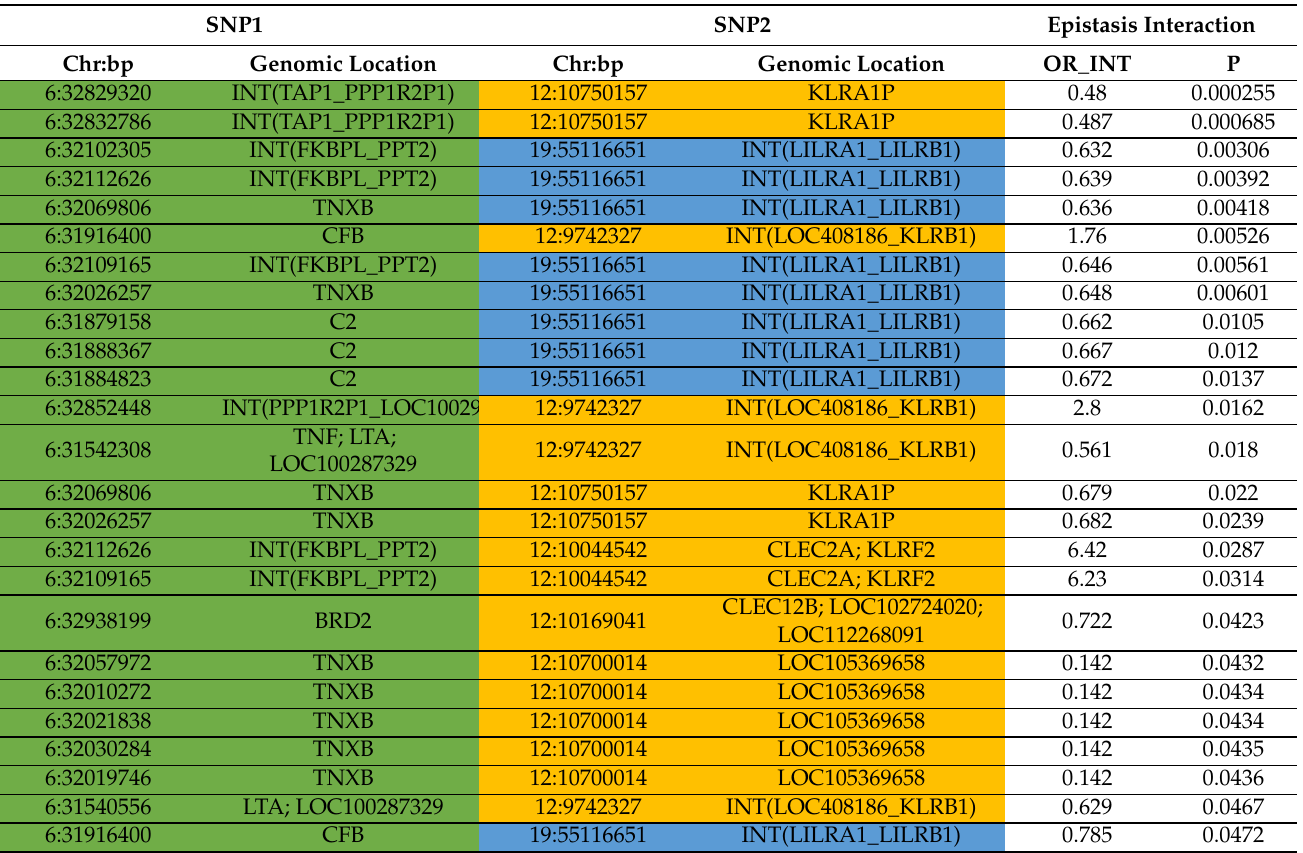
Table 6. Epistasis results on the panel of SNPs identified by the combined FDR results (Table S2) performed using a merged discovery and replication dataset. Epistatic interactions were only considered for SNPs in different loci for HLA (green), NKC (orange) and LRC (blue), and not within genomic